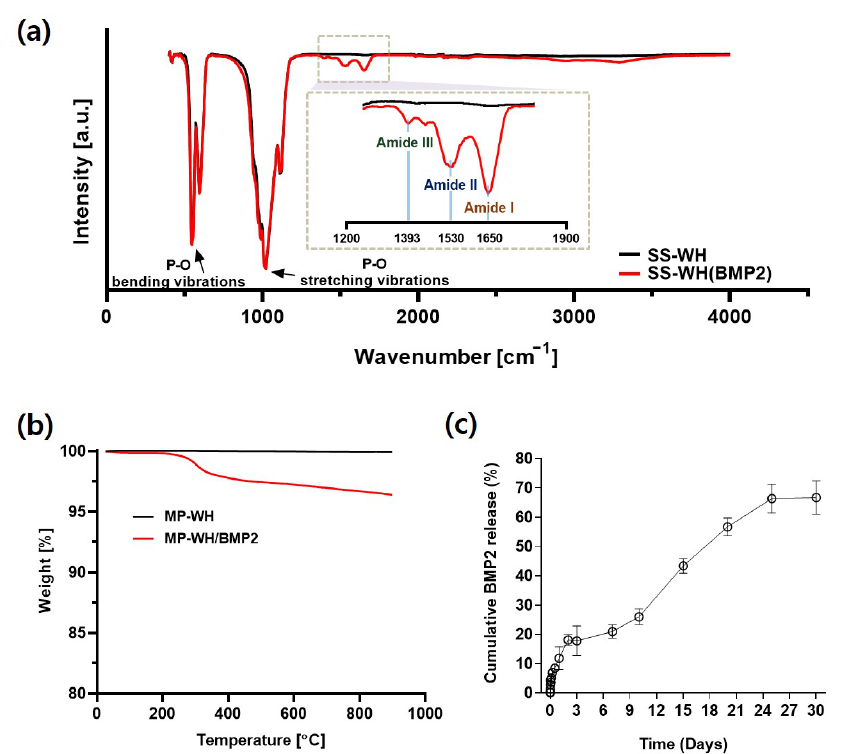
Figure 3. Physicochemical characterization of BMP2-coated MP-WH granules: ( a ) FT-IR spectra of BMP2-incorporating MP-WH granules, ( b ) TGA of BMP2-coated MP-WH granules, and ( c ) cumu- lative release of BMP2 from MP-WH/BMP2 granules for 30 days. The supernatant is collected at specific time points and the concentration is detected using the ELISA method. The reported values are means ±